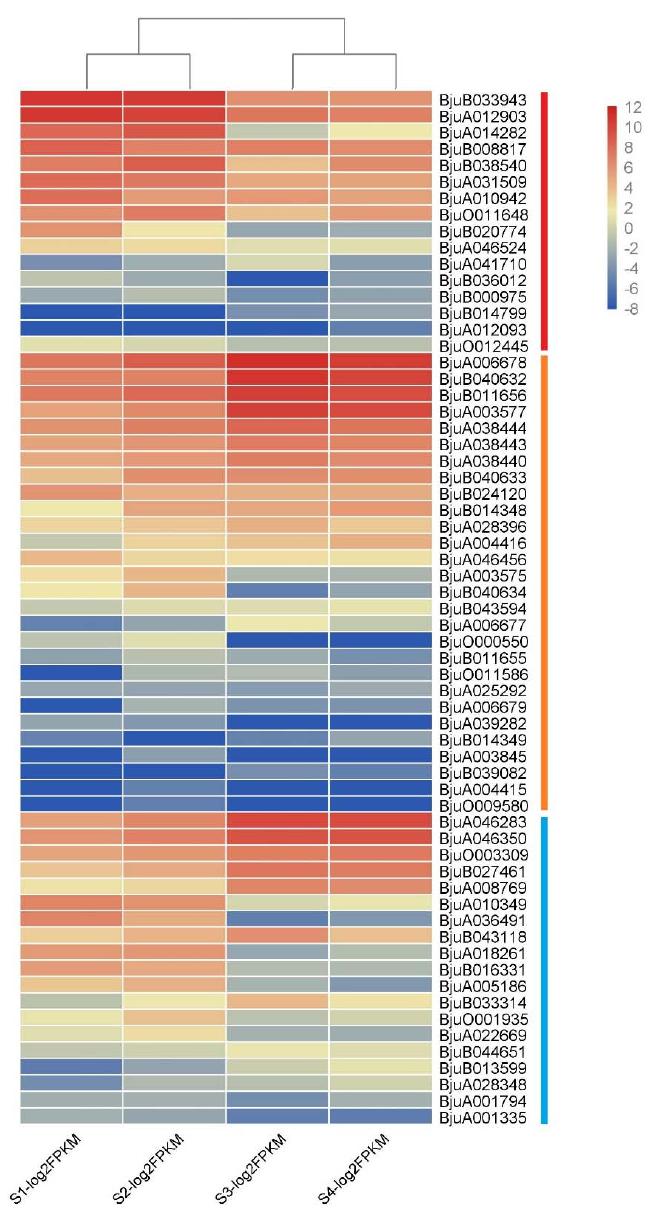
Figure 9. Expression levels of BjuXTH genes at different developmental stages in stem swelling. Fragments per kilobase per million (FPKM) values of BjuXTH genes were transformed by log2, and the heatmap was constructed with Multiexperiment Viewer